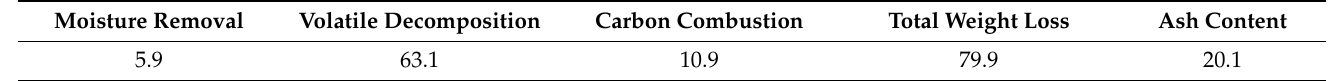
Table 3. Thermogravimetric analysis results of rice husk (wet basis